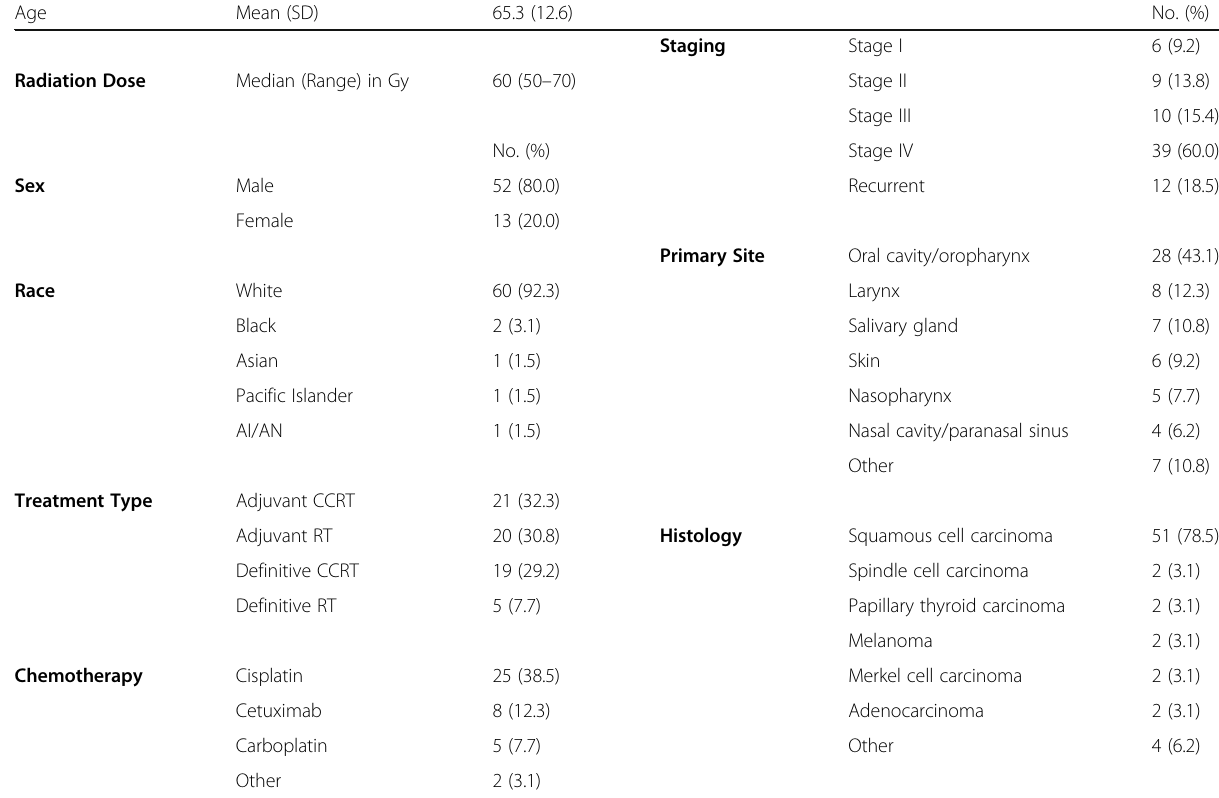
Table 1 Patient, disease, and treatment characteristics ( N = 65)